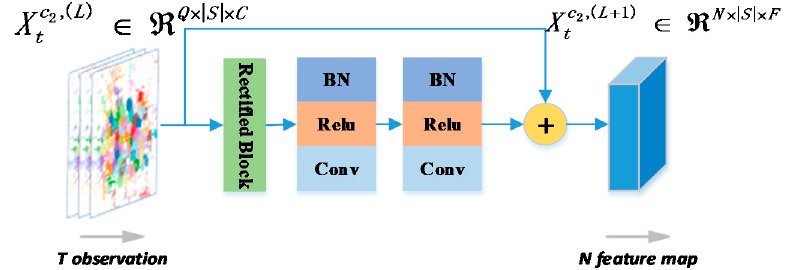
Figure 4. The fine-grained temporal correlation modelled by stacking a rectified block and a Batch Normalization (BN)–Rectified Linear Unit (ReLU)–Convolution (Conv) (BRC) block within one residual connection. Note that there are several residual connections in our model.